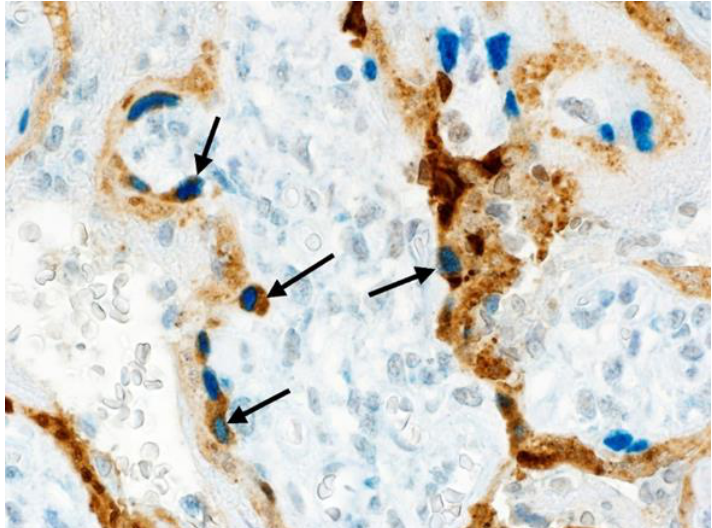
Figure 6. Multiple scattered cytotrophoblast cells (arrows) exhibit intracytoplasmic positivity for SARS-CoV-2 nucleocapsid protein (brown). Cytotrophoblast staining for SARS-CoV-2 nucleocapsid protein is identified using double-staining immunohistochemistry with antibodies to SARS-CoV-2 nucleocapsid protein (brown, cytoplasm) and GATA3 (blue, nucleus). The cytotrophoblast staining positive for viral antigen are in intimate contact with the overlying syncytiotrophoblast, which also stains positive. Note that there are cytotrophoblast cells (blue nuclei, clear cytoplasm) that do not demonstrate intracytoplasmic staining for SARS-CoV-2 antigen. Double staining with antibodies to GATA3 and SARS-CoV-2 nucleocapsid protein, ×40.